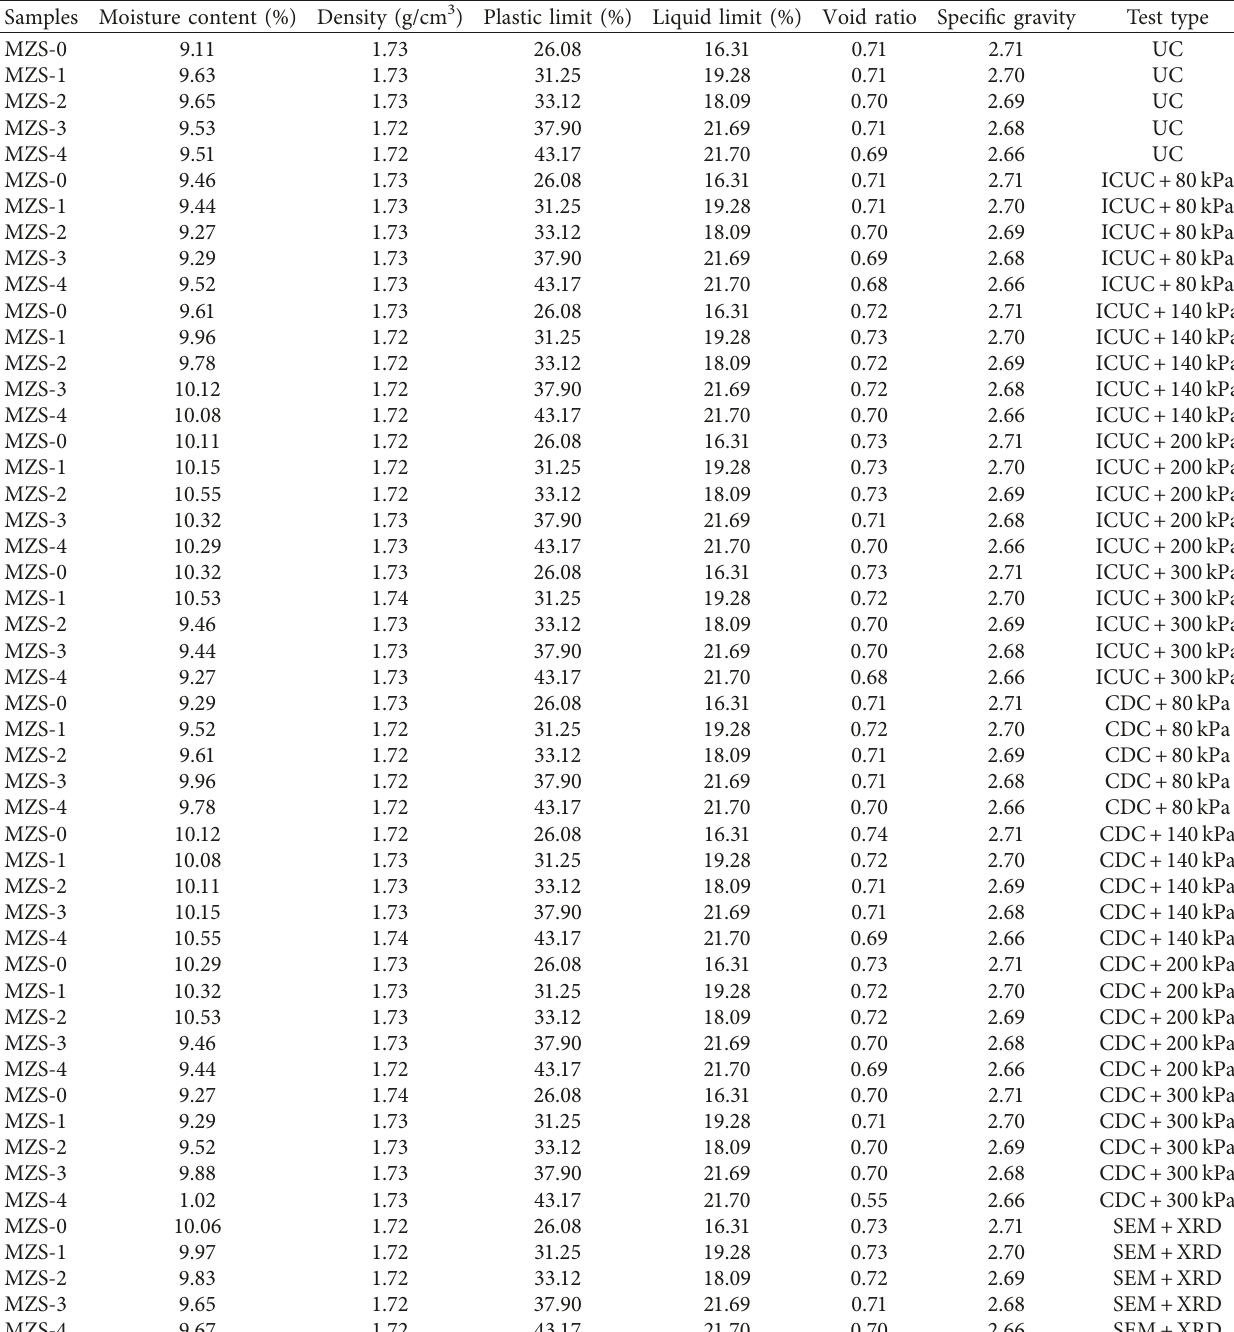
Table 1: Summary of tests in the